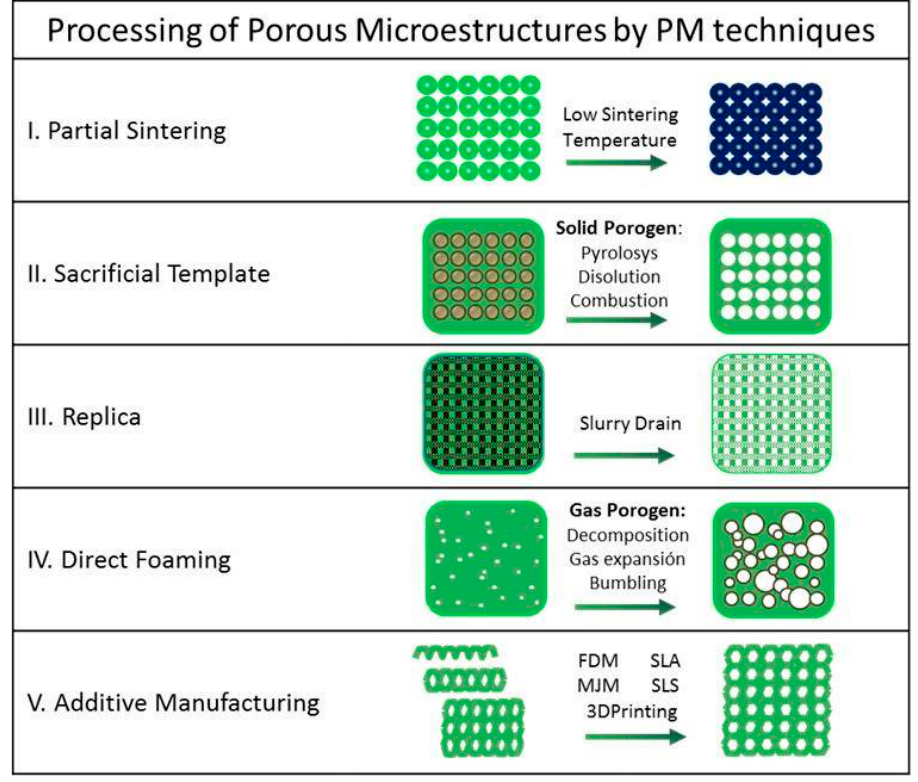
Figure 1. Scheme of Powder Metallurgy techniques for porous metal processing.